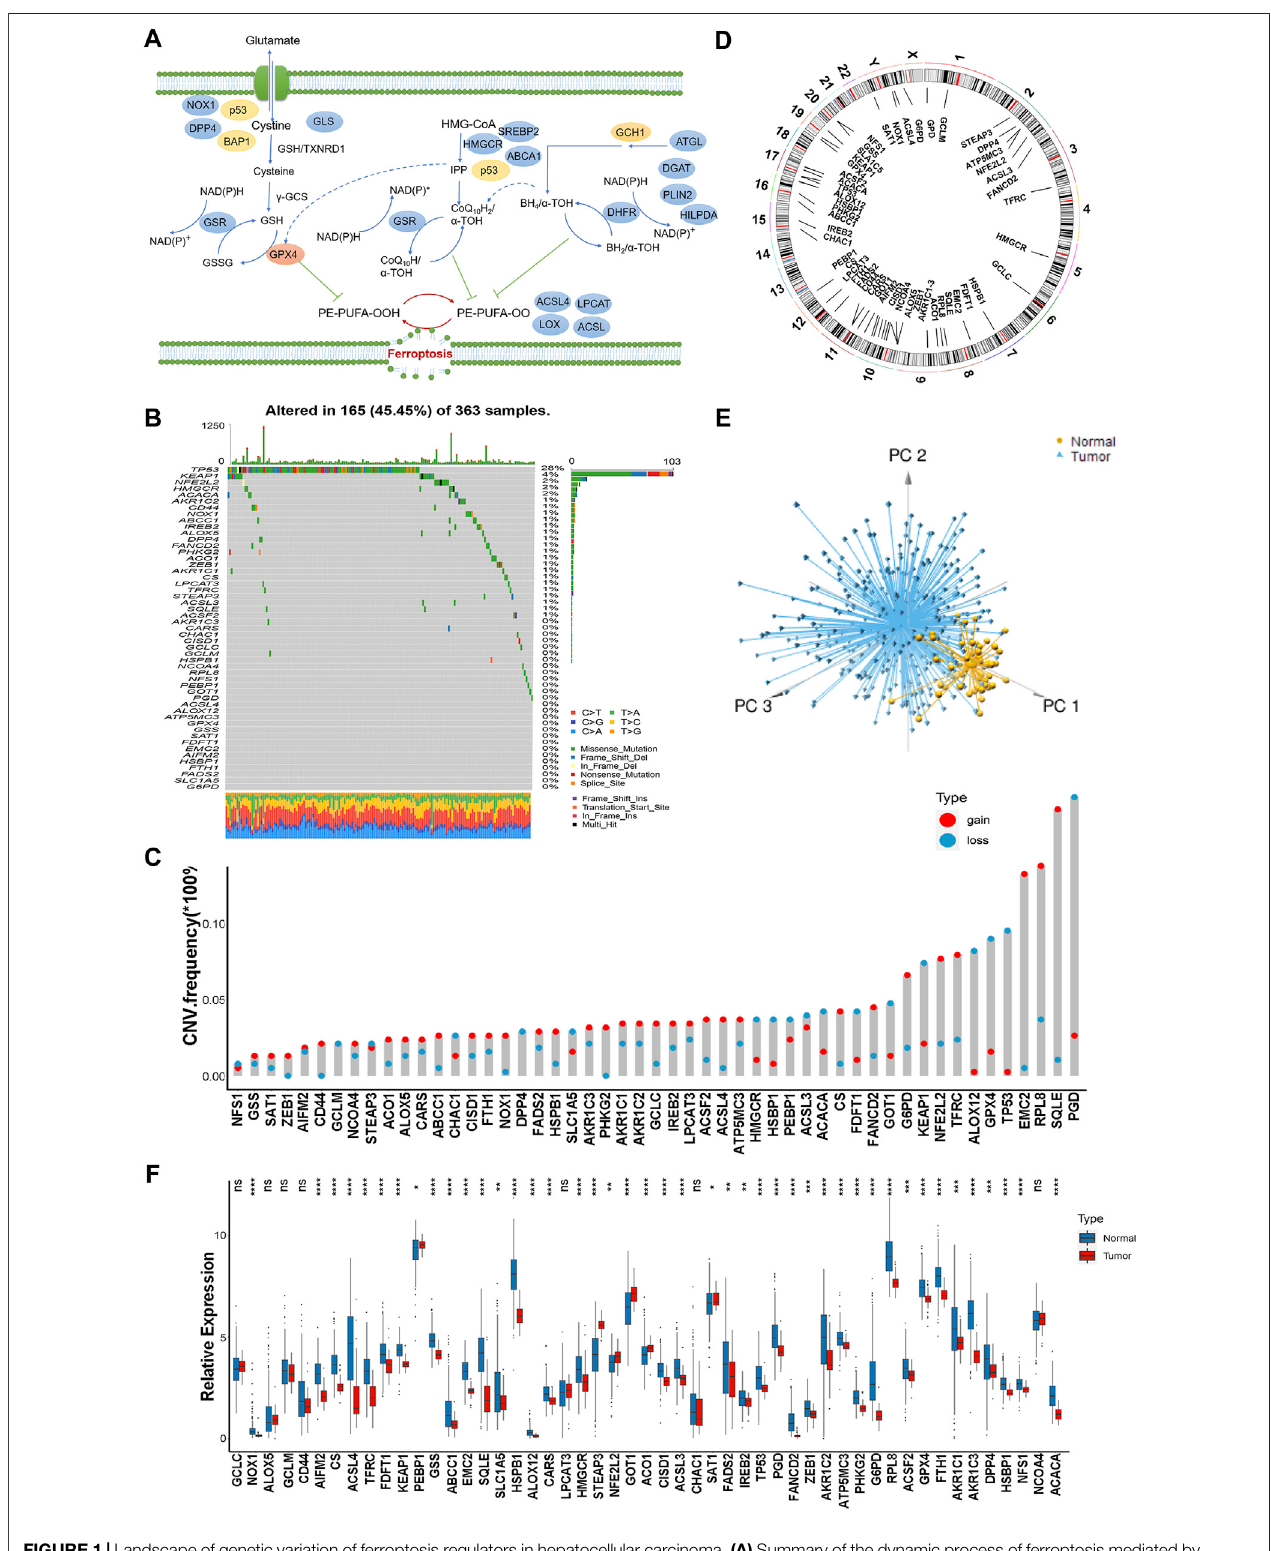
FIGURE 1 | Landscape of genetic variation of ferroptosis regulators in hepatocellular carcinoma. (A) Summary of the dynamic process of ferroptosis mediated by regulators. (B) Atotalof165of363HCCsamplesexperiencedgeneticalterationsofferroptosisregulatorsfromTCGA-LIHCcohort.Eachcolumnrepresented individual patients. The number on the right showed the mutation frequency of each regulator. The barplot on the right indicated the proportion of each variant type. (C) The CNV